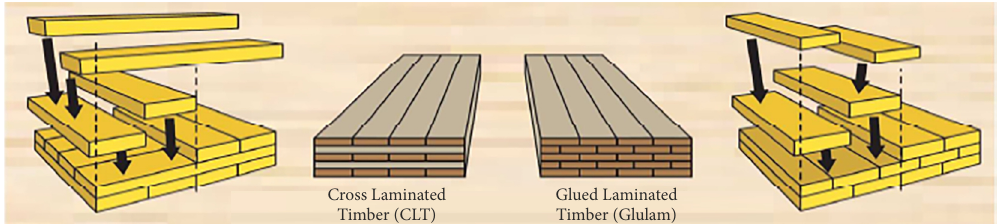
Figure 1. Difference between CLT and glulam (Avellan,